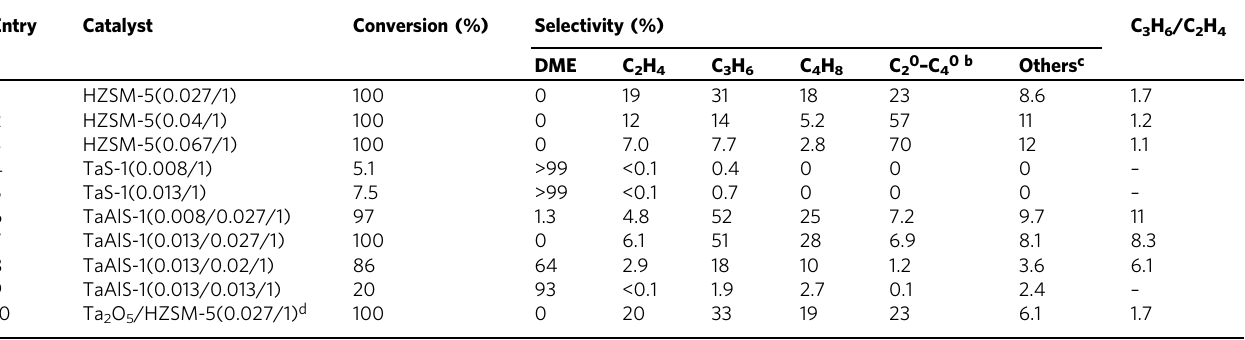
Table 1 Summary of the methanol conversion and product selectivities over different catalysts in MTO reactions a